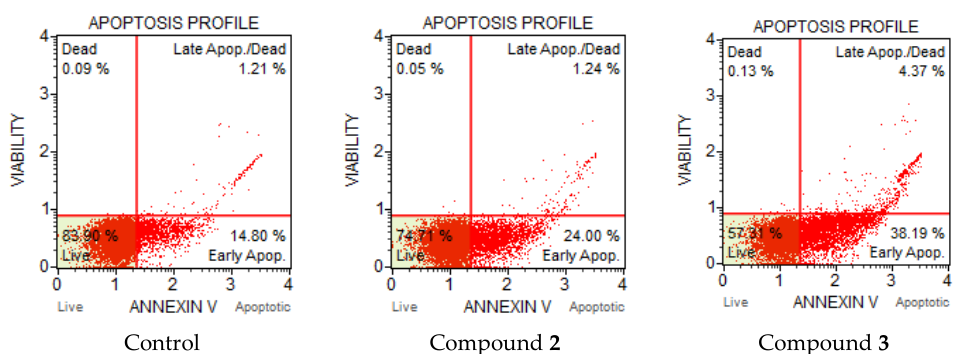
Figure 6. Apoptotic profile of A-549 cancer cells after treatment with compounds 2 and 3 at μM after 48 h. Concentration of compounds 2 × IC 50 . 48 h. Concentration of compounds 2 × IC 50 .